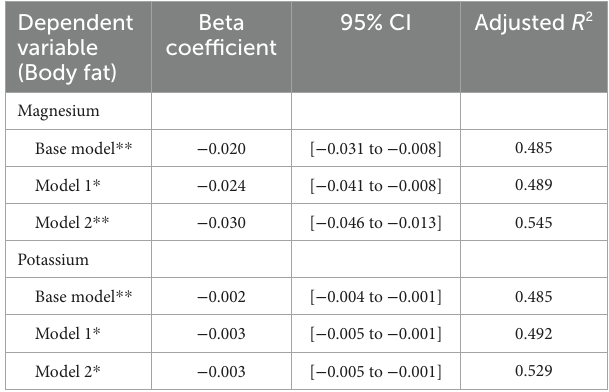
TABLE 4 Multivariate analysis of associations between dietary magnesium, potassium, and body